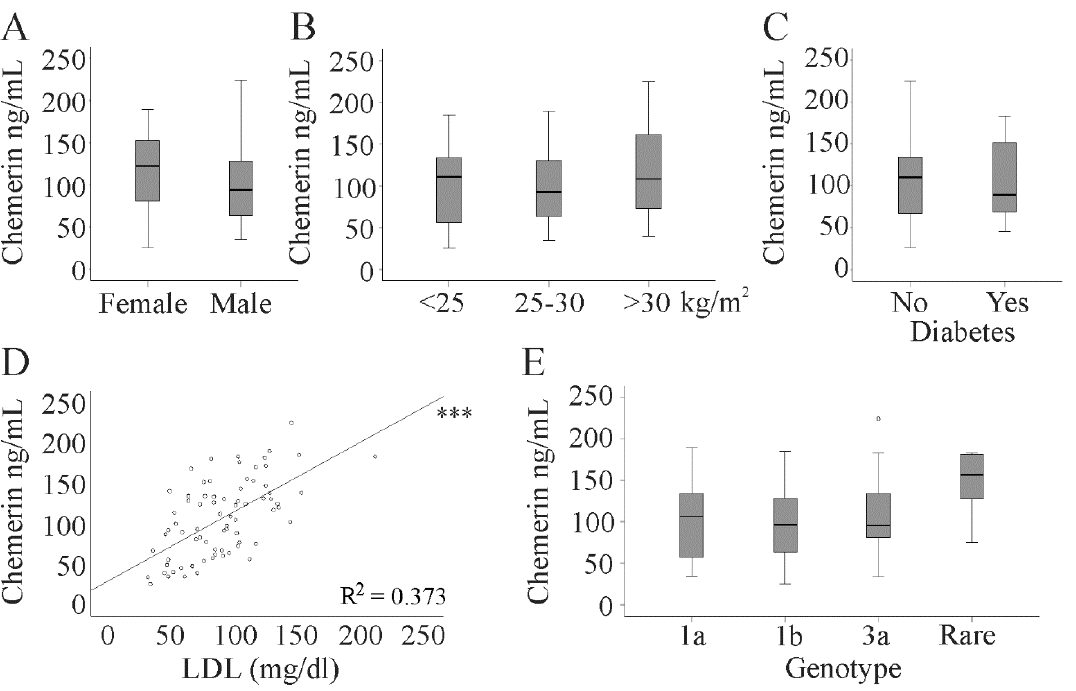
Figure 1. Serum chemerin level in 82 patients with chronic hepatitis C virus (HCV). ( A ) Serum chemerin in 33 female and 49 male HCV patients; ( B ) chemerin levels in patients stratified for body mass index (BMI); ( C ) chemerin in 18 patients with and 64 patients without diabetes; ( D ) correlation of chemerin with low-density lipoprotein (LDL) (R 2 = 0.373); ( E ) chemerin in patients stratified for HCV genotype (Rare is the group of 6 patients with genotypes other than 1a, 1b, and 3a). The small circle above the box marks an outlier. *** p < 0.001. Table 1. Spearman correlation coe ffi cients and p-values of the correlations of BMI and laboratory parameters and chemerin in the whole cohort before direct-acting antiviral (DAA) therapy, at 4 and 12 weeks after start of therapy and 3 months after the end of therapy. Significant correlations are in